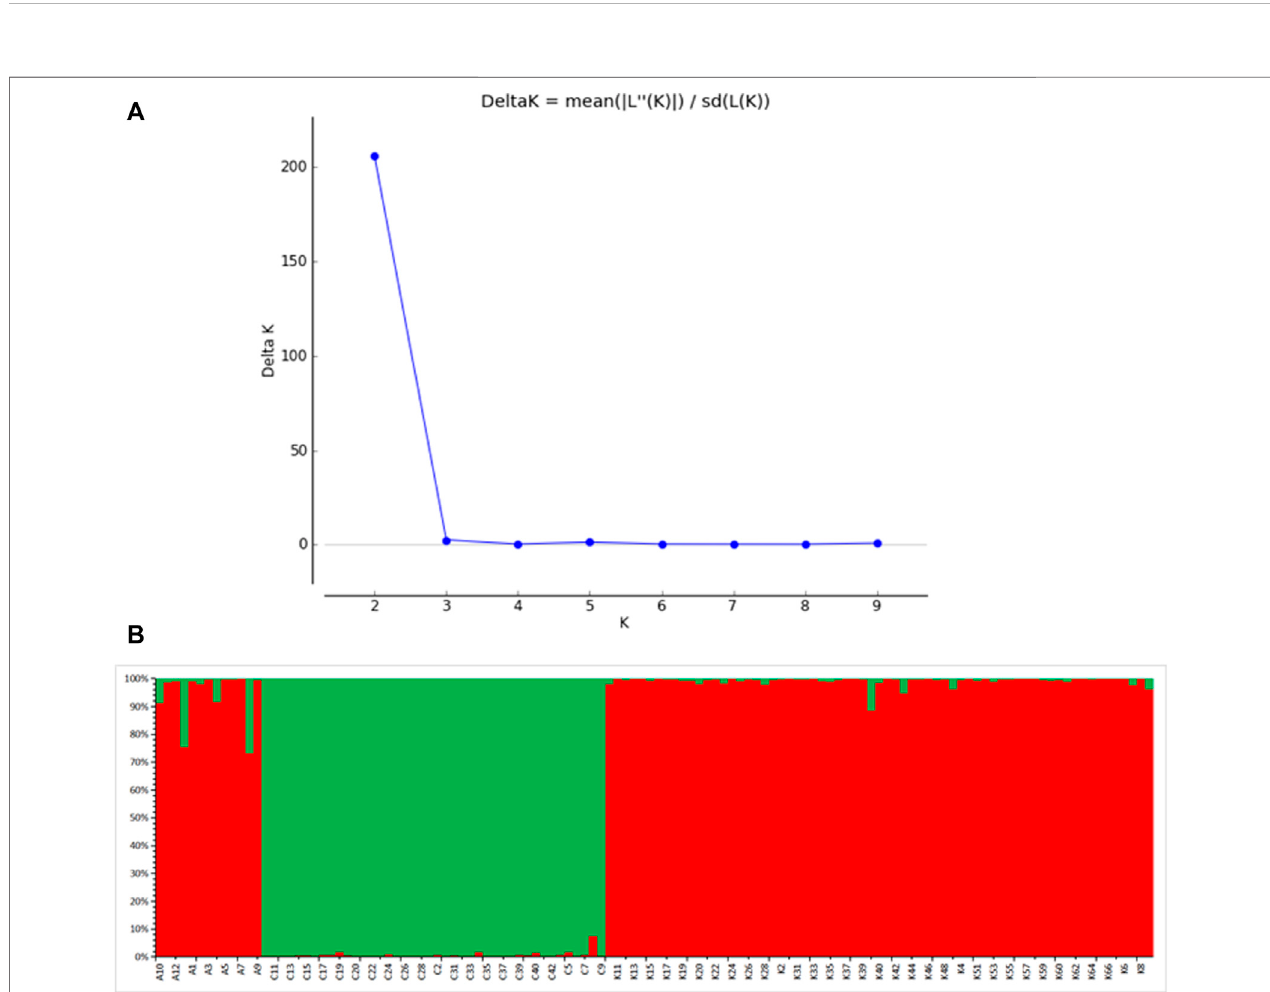
FIGURE 5| Model choice criterion lnP (D) of the structure analysisfor each K value (A) ; K = 2, structure analysis in all three Schizothorax biddulphi populations (B) , CEC (green), and other two populations (red).